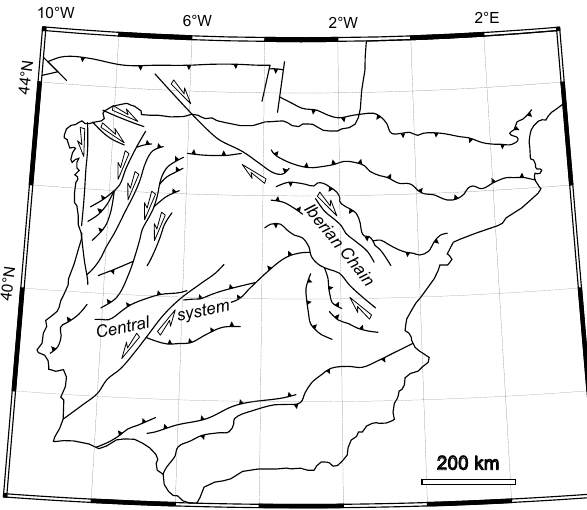
Fig. 20. Cenozoic tectonic sketch map of the Iberian Peninsula (af- ter De Vicente et al.,